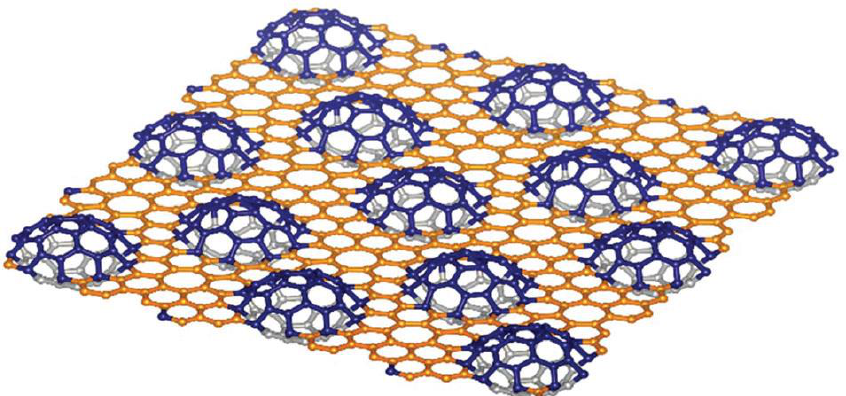
Figure 9. Schematic illustration showing the structures of various bubble-wrap allotropes. Adapted with permission from Reference [141]. Copyright (2018) Royal Society of Chemistry.